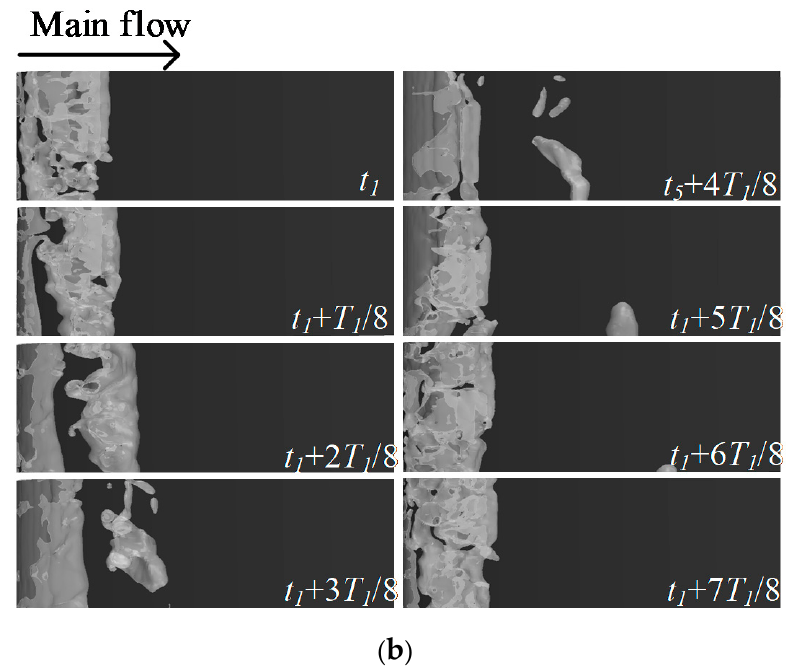
Figure 7. Comparison of the cavity evolution for a typical cycle for no free surface case and near the free surface case ( h = 0.25 C ). ( a ) Cavity evolution in a typical cycle for the no free surface case, ( b ) Cavity evolution in a typical cycle for the near free surface case ( h = 0.25 C ).